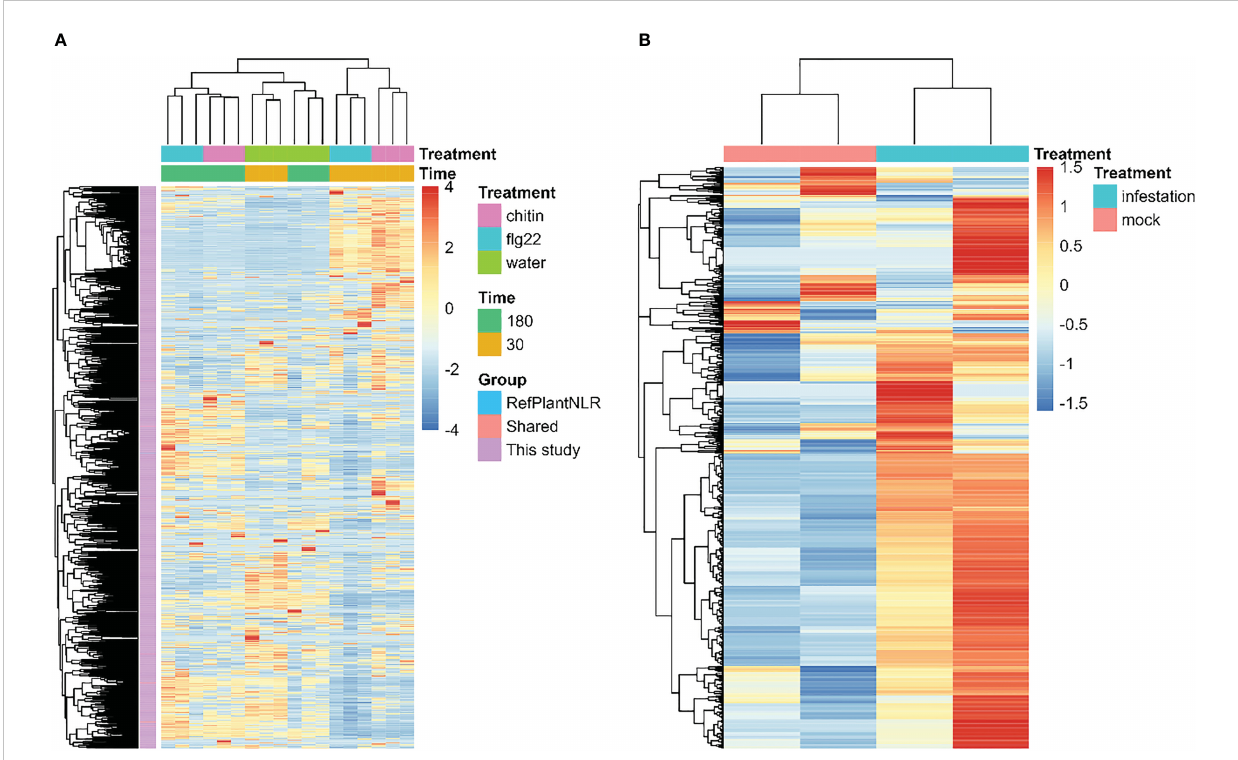
FIGURE 4 (A) : Wheat ( Triticum aestivum ) NLR gene expression patterns according to both RefPlantNLR and PlantNLRatlas. The heatmap was created using FPKM (fragments per kilobase of transcript per million mapped reads) values. Genes identi fi ed in both RefPlantNLR and PlantNLRatlas are annotated as “ shared NLR genes ” . (B) : Heatmap of soybean ( Glycine max ) NLR gene expression patterns in response to challenge by soybean aphid ( Aphis glycines ), according to